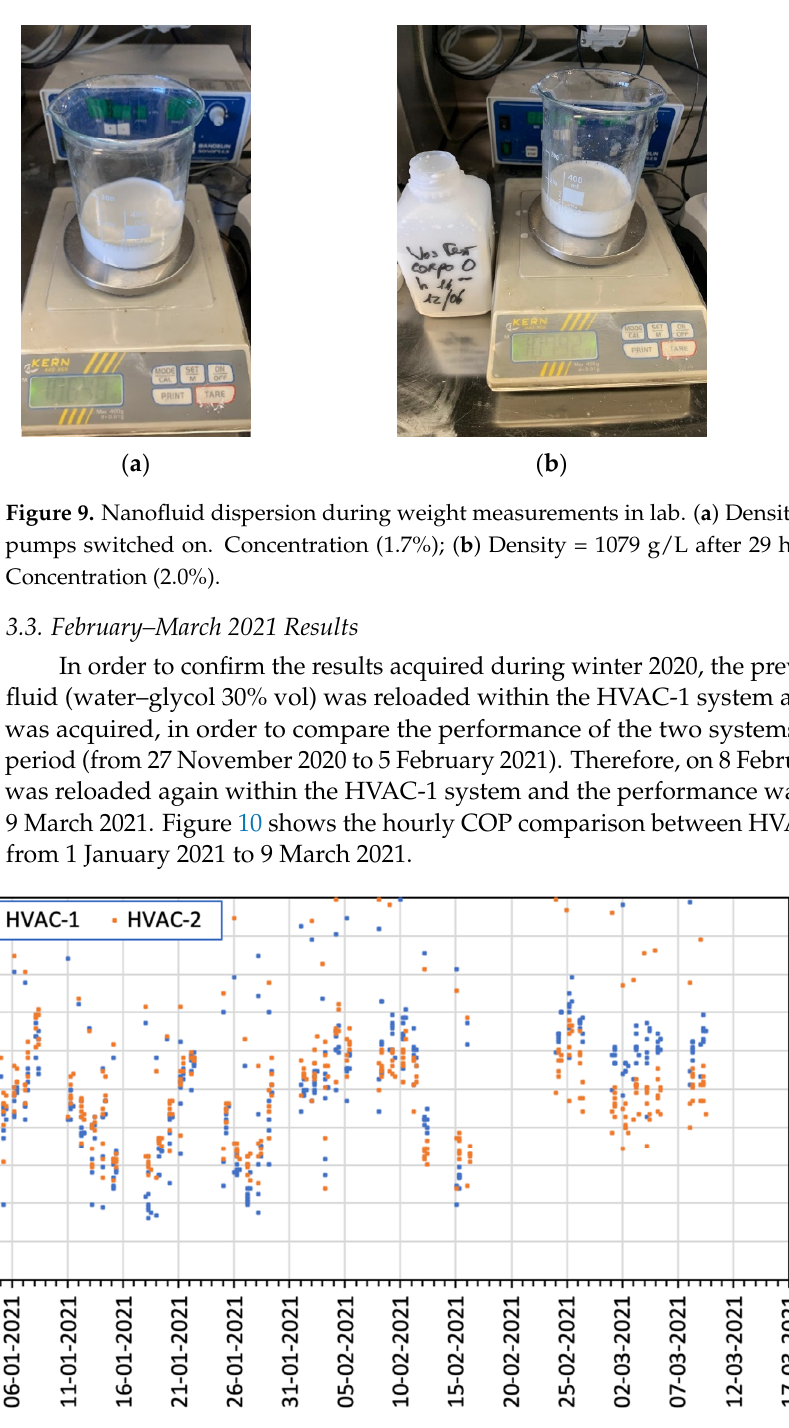
Figure 10. Hourly COP comparison between HVAC-1 and HVAC-2 (1 January 2021–9 March 2021). It can be seen that the hourly COP values related to the HVAC-2 (orange dots), until 5 February are mainly higher than the HVAC-1 values. After loading the nanofluid (8 February) the trend reverses, with blue dots over orange ones.